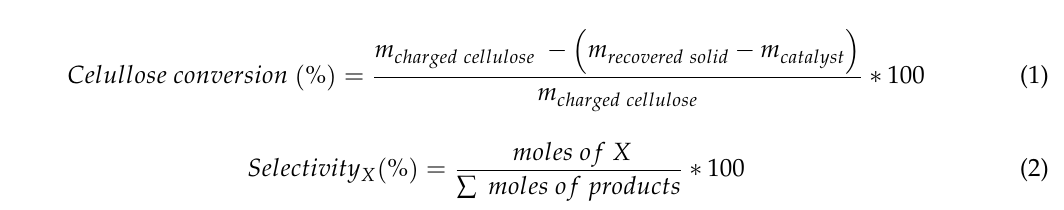
Figure S1: N 2 adsorption isotherms ( a ) of samples T, TSu, TS Ru-T, ( b ) of samples Ru-TSu and Ru-TS. Figure S2: TPD profiles of samples T, TSu, and TS: ( a ) CO 2 , ( b ) CO. Figure S3: Total acidity (from titration measurements) vs amount of CO 2 determined by TPD (data of Table 2). Figure S4: XPS data corresponding to Cl 2p in samples Ru-T, Ru-TSu, and Ru-TS. The fitting curves shown are those obtained for catalyst Ru-T and are included only to show the position of the XPS signals. Figure S5: TEM images and Ru particle size distribution of catalysts ( a ) Ru-T, ( b ) Ru-TSu, and ( c ) Ru-T. Figure S6: Schematic representation of the molecular form of the main reaction products. InfoS1: BET and Dubinin–Radushkevich